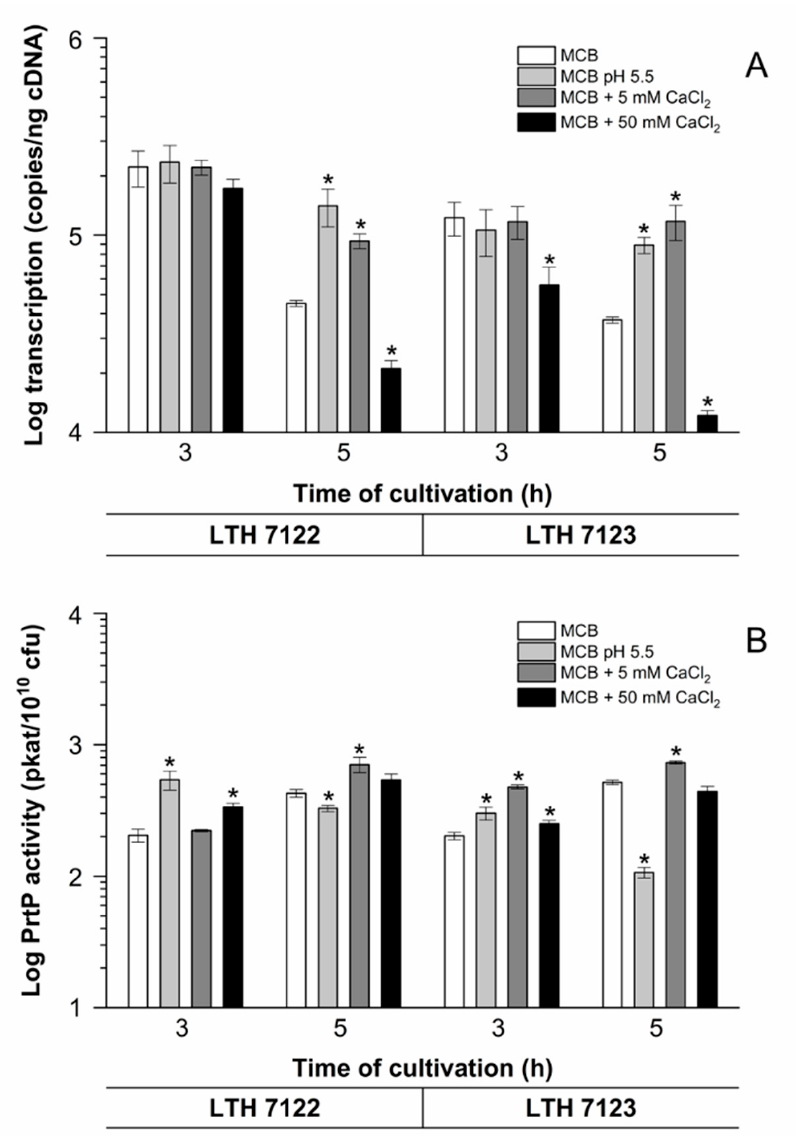
Figure 4. prtP transcription ( A ) and PrtP peptidase activity ( B ) of strains L. lactis LTH 7122 and LTH 7123 during growth in basic MCB (pH 6.6), MCB (pH 5.5), and basic MCB (pH 6.6) with addition of 5 mM or 50 mM calcium chloride. Samples were collected after 3 h and 5 h of cultivation. The mean values and standard deviations of three biological and two technical replicates each are shown. Asterisks (*) show statistical significance compared to the reference (basic MCB, pH 6.6) ( p <